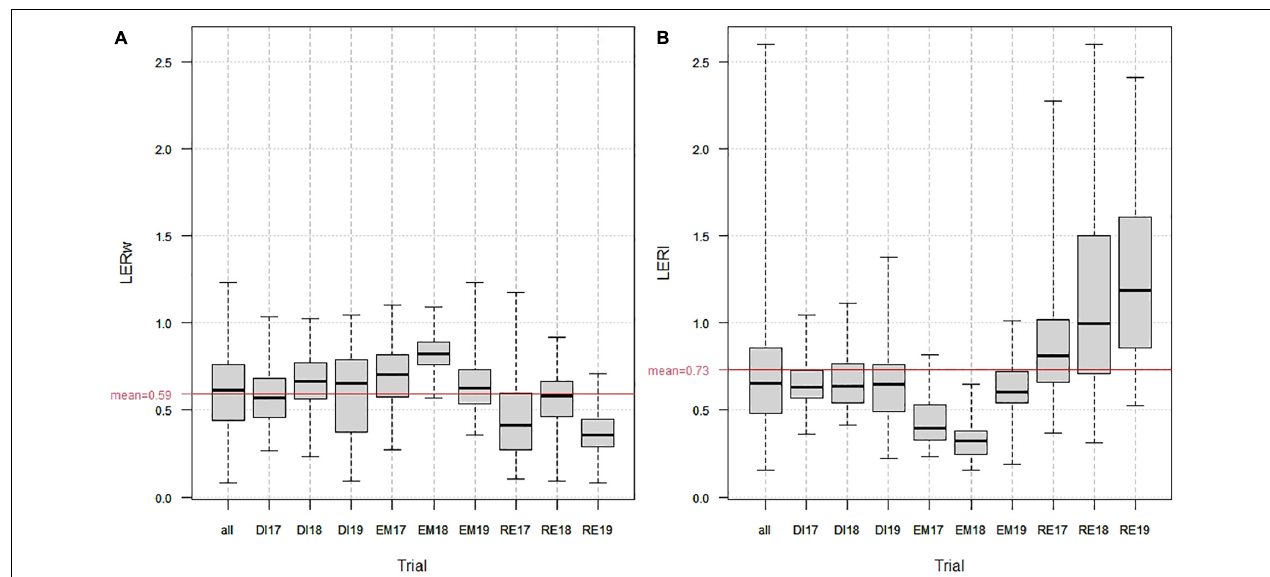
FIGURE 2 | Distribution of partial Wheat (A) and Legume (B) Land Equivalent Ratios over the 9 environments (all) and for each environment (DI, Dijon; EM, Estrées-Mons; RE, Rennes; 17, 2016/2017 trial; 18, 2017/2018 trial; 19, 2018/2019 trial). The red bars show the LERw (A) and LERw (B) means across all environments.